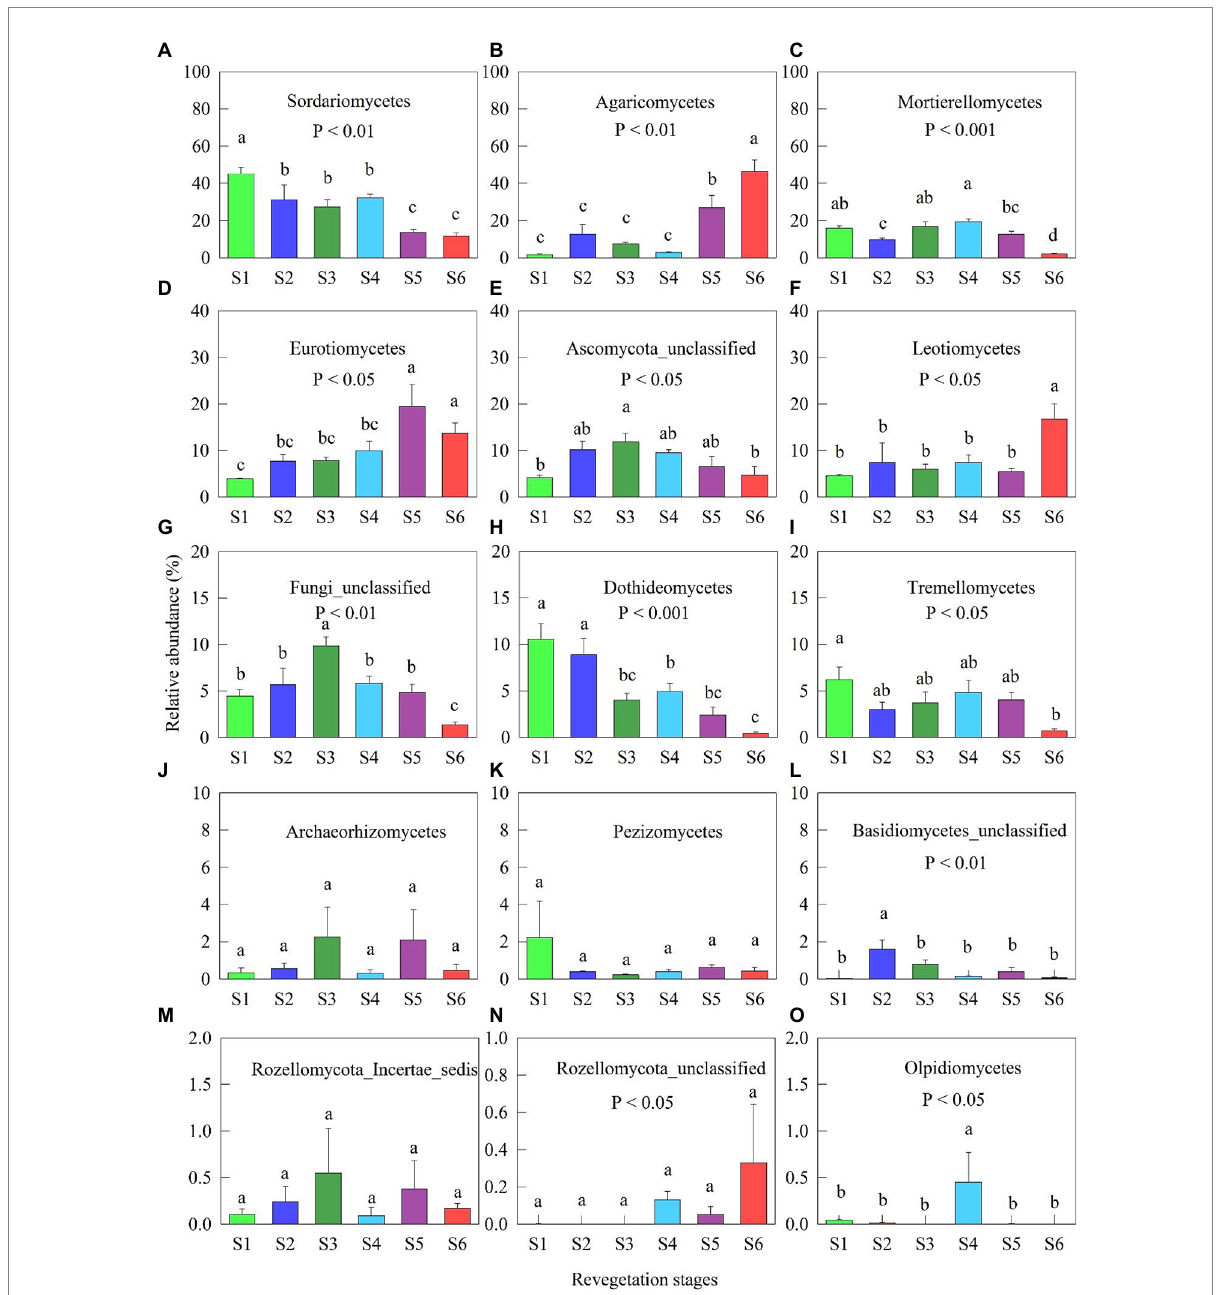
FIGURE 2 Relative abundance (% of individual taxonomic groups) of the dominant fungal classes (mean ± SE, n = 4) present in the microbial communities during various revegetation stages in the Loess Plateau of China. Different superscript lower-case letters imply statistically significant differences at the α = 0.05 level among revegetation stages. S1: Farmland stage (the control); S2: Pioneer weed stage; S3: Herb stage; S4: Shrub stage; S5: Early forest stage; and S6: Climax forest